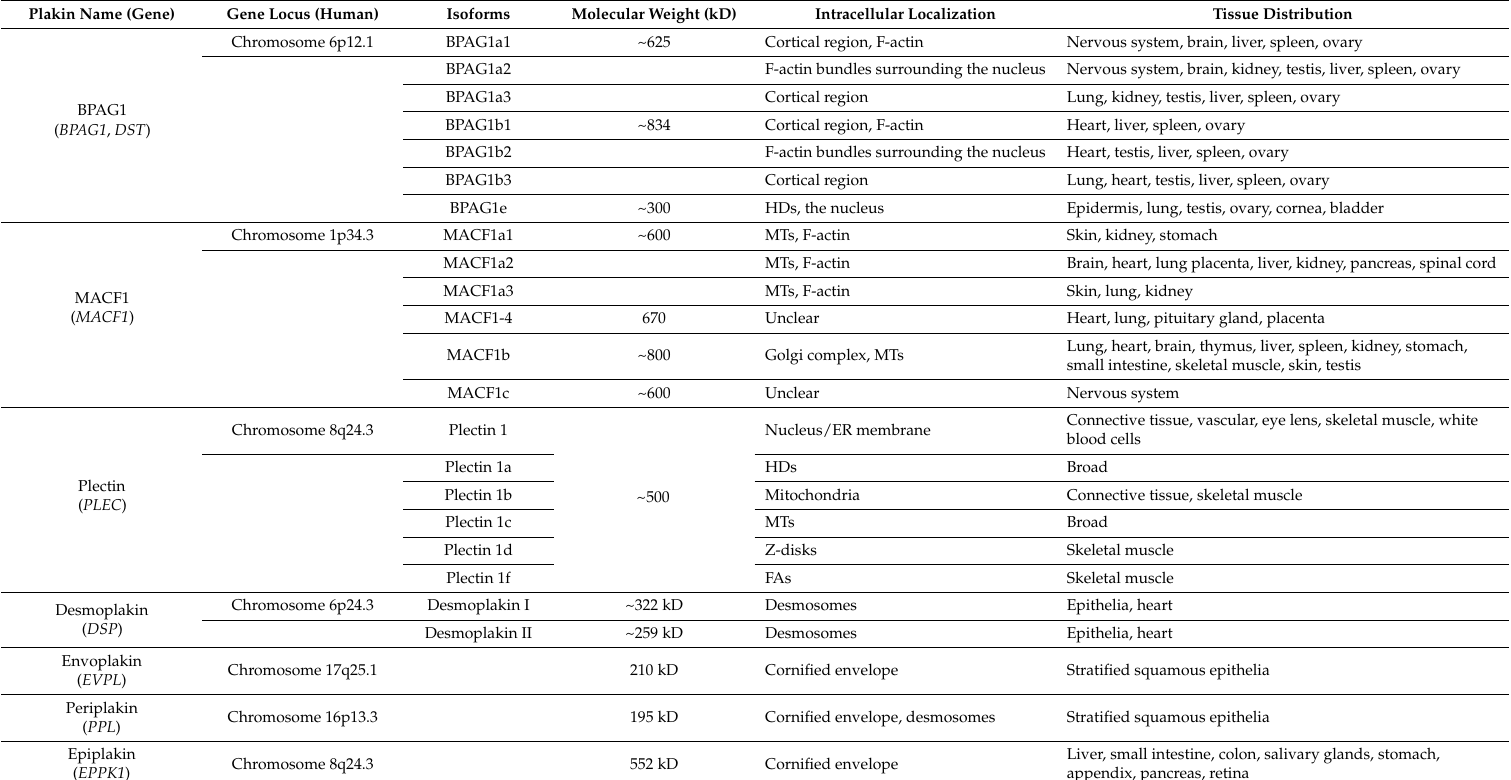
Table 1. Mammalian plakin members, isoforms, intracellular localization, and tissue